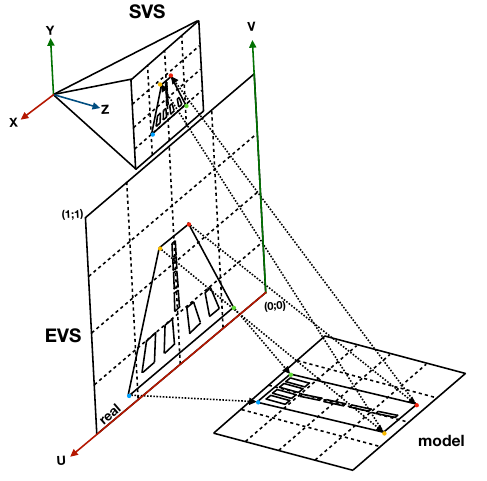
Figure 3. Enhanced vision system image re-projection for conform representation on the pilot’s HUD.